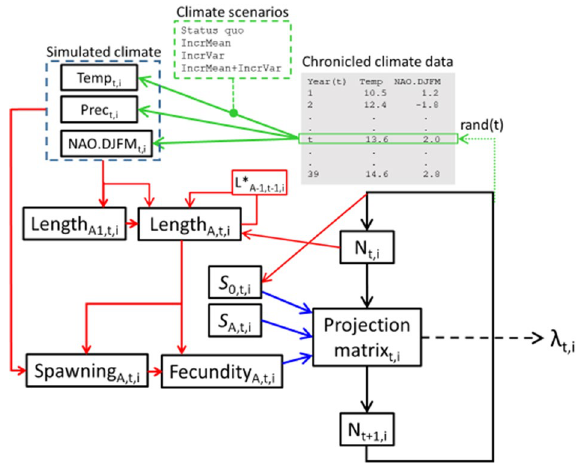
Figure 6. A schematic overview of the processes involved in our model-setup. Red lines indicate drivers and connections acting on individual life history traits, blue lines indicates traits driving the population model and green lines indicates links to climate variables. In short, existing area and time specific climate data on summer precipitation (Prec) and mean summer air temperature (Temp), as well as time specific data on winter NAO- index (recorded NAO values during December, January, February and March, NAO.DJFM), were used to parameterize models for length at age 1 and length at age > 1, as well as spawning probability at age. Length at age 1 was allowed to affect length at age > 1, and in the simulations achieved length at age > 1 was also influenced by the achieved length the previous year (L*). Length at age and spawning probability, both defined by climate variables, interacted in defining how many eggs a female was likely to produce (i.e. fecundity). Survival from eggs to small juvenile fish was based on a stock-recruitment relationship, where the stock was defined by